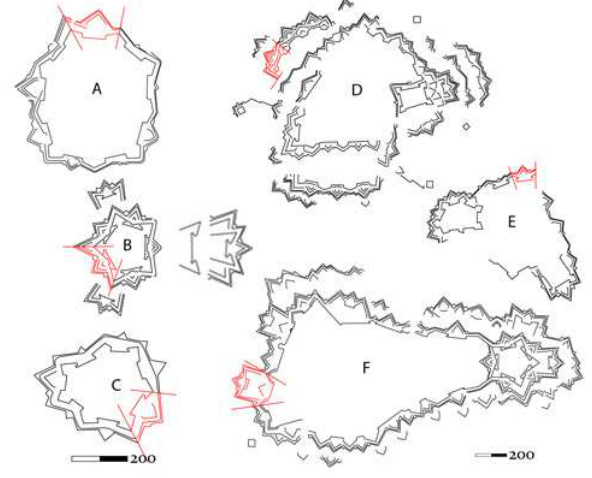
Figure 6. Regulating lines of the fortified sites of Toul (A), Huningue (B), Marsal (C), Metz (D), Verdun (E) and Strasbourg (F). The scale bars show the distance of 200 toises (approximately 190 metres). The red areas represent a front.